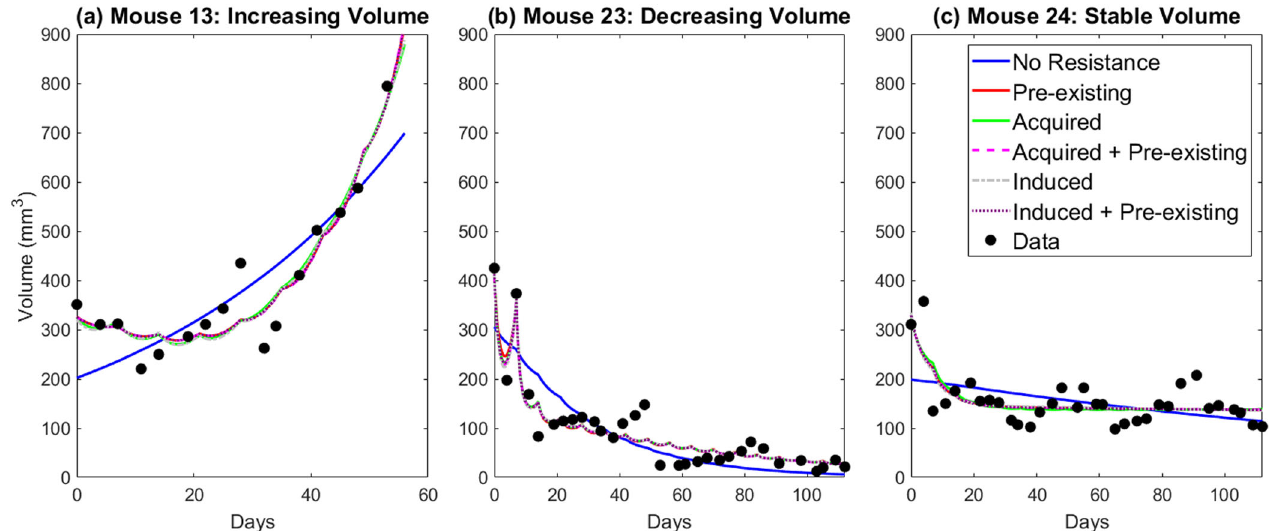
Fig. 4 Best fi t of six proposed resistance models to treatment data for three representative mice. a Mouse 13 representing the case where the tumor volume increases in spite of treatment. b Mouse 23 representing the case where the tumor volume decreases during treatment. c Mouse 24 representing the case where the tumor volume remains relatively stable during